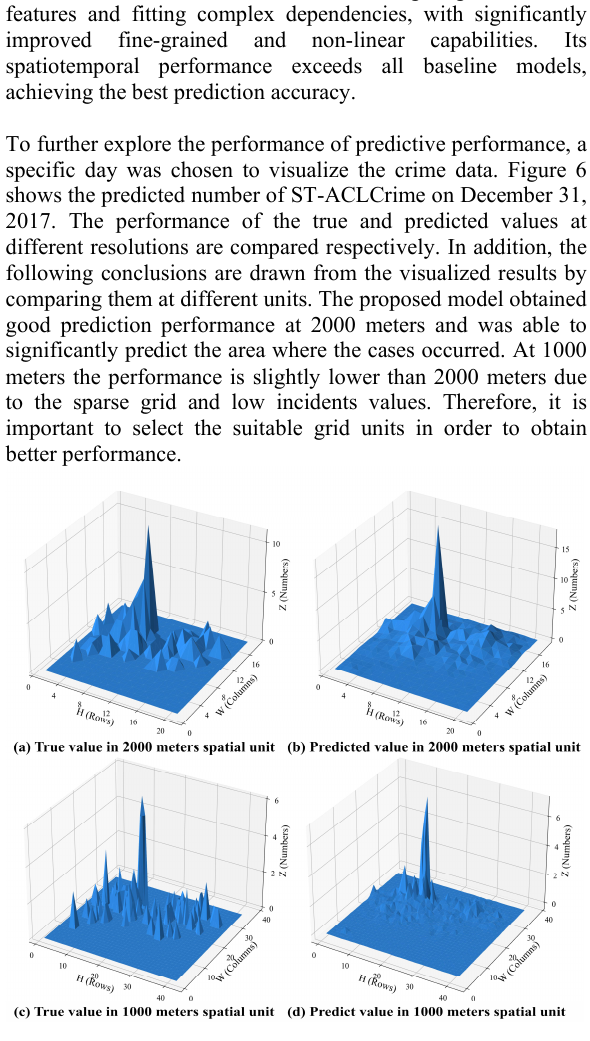
Figure 6 . ST-ACLCrime predictions for December 31, 2017 at two-level spatial resolution,